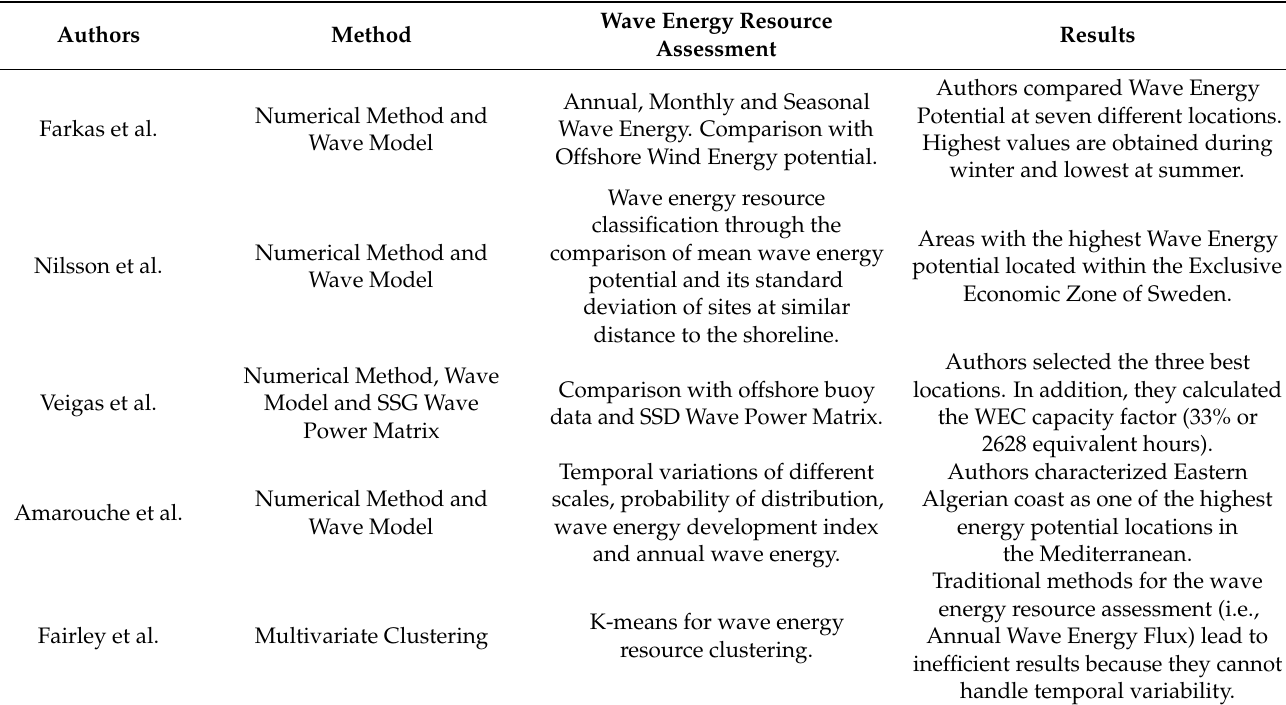
Table 1. Related work for the assessment of wave energy resource.